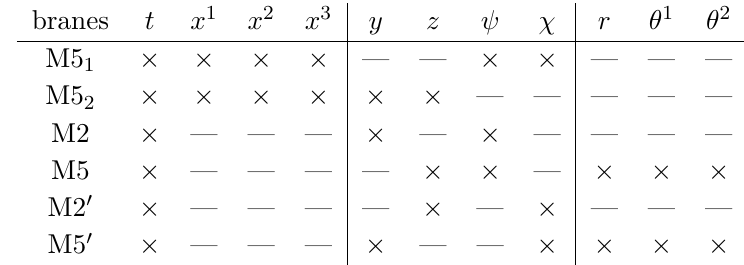
Table 8 . BPS/8 intersection describing M2-M5-M2 0 -M5 0 branes ending on a M5 1 -M5 2 bound state. This system defined a N = 4 line defect within the N = 2 4d CFT living in the M5 Therefore, the ρ → 0 limit of the background defined by (A.5) gives rise to a new class of N = 4 solutions described by AdS M5 -M5 brane 1 2